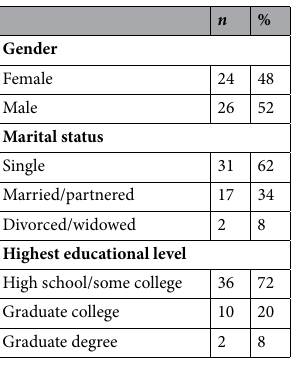
Table 1. Demographic characteristics of the sample. N = 50. Participants were on average 29.12 years old ( SD =